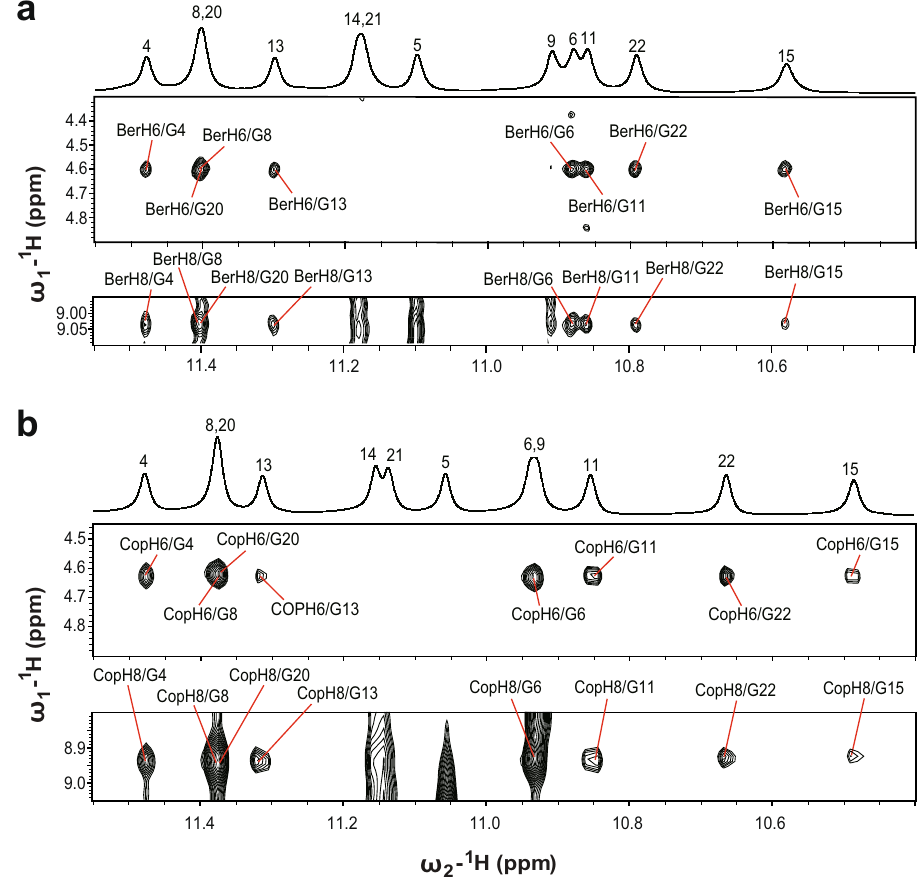
Fig. 6 | 2D NMR spectra of KRAS – G4 in complex with berberine and coptisine. Select regions of the 2D-NOESY spectra of 3:1 berberine- KRAS -G4 ( a ) and 2.5 :1 coptisine- KRAS -G4 ( b ) complexes in H 2 O showing intermolecular cross-peaks